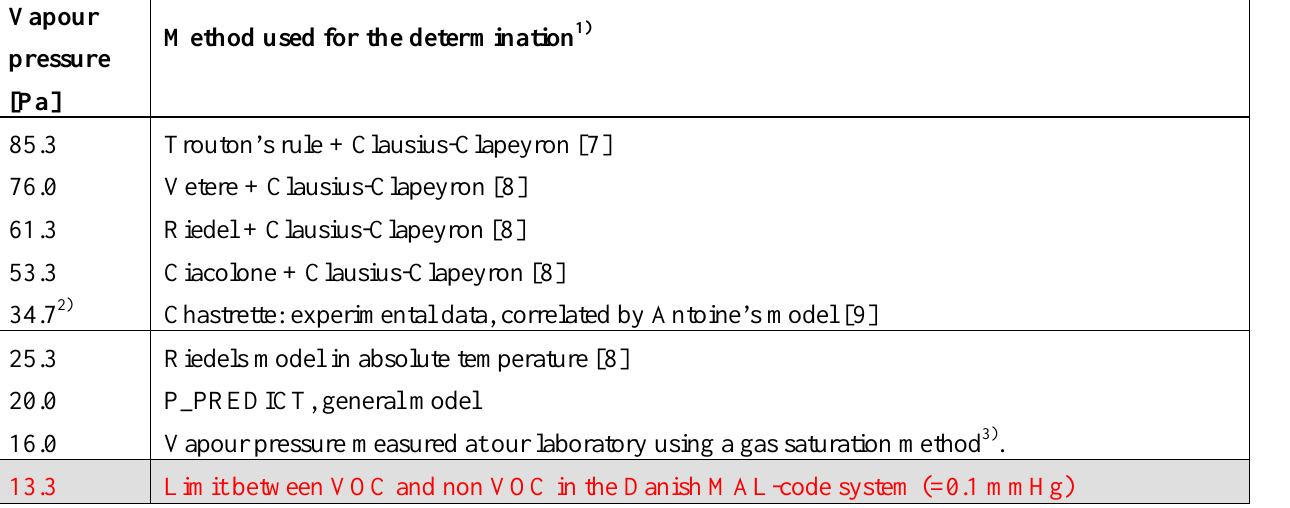
Table 2. Experimental and predicted values for the vapour pressure of liquid n-dodecane at 20 o C Vapour